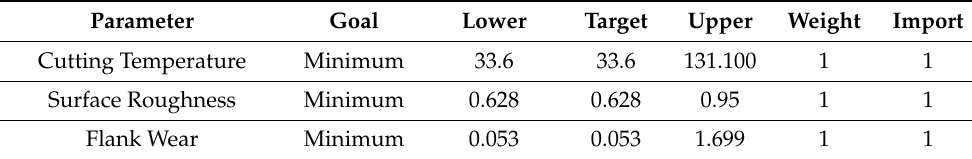
Table 7. Response surface methodology parameter design.